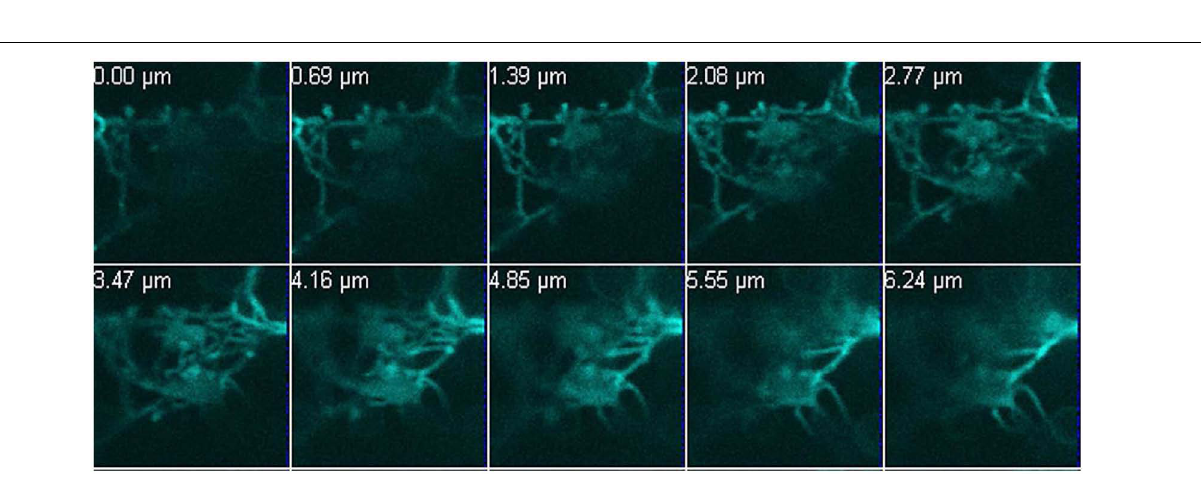
FIGUREA3 |A network formed by the fluorescently labelled GAPDH. A 13-µm deep Z-stack was performed to demonstrate the filamentous structures of GapC1:CFP in three dimensions in the examined